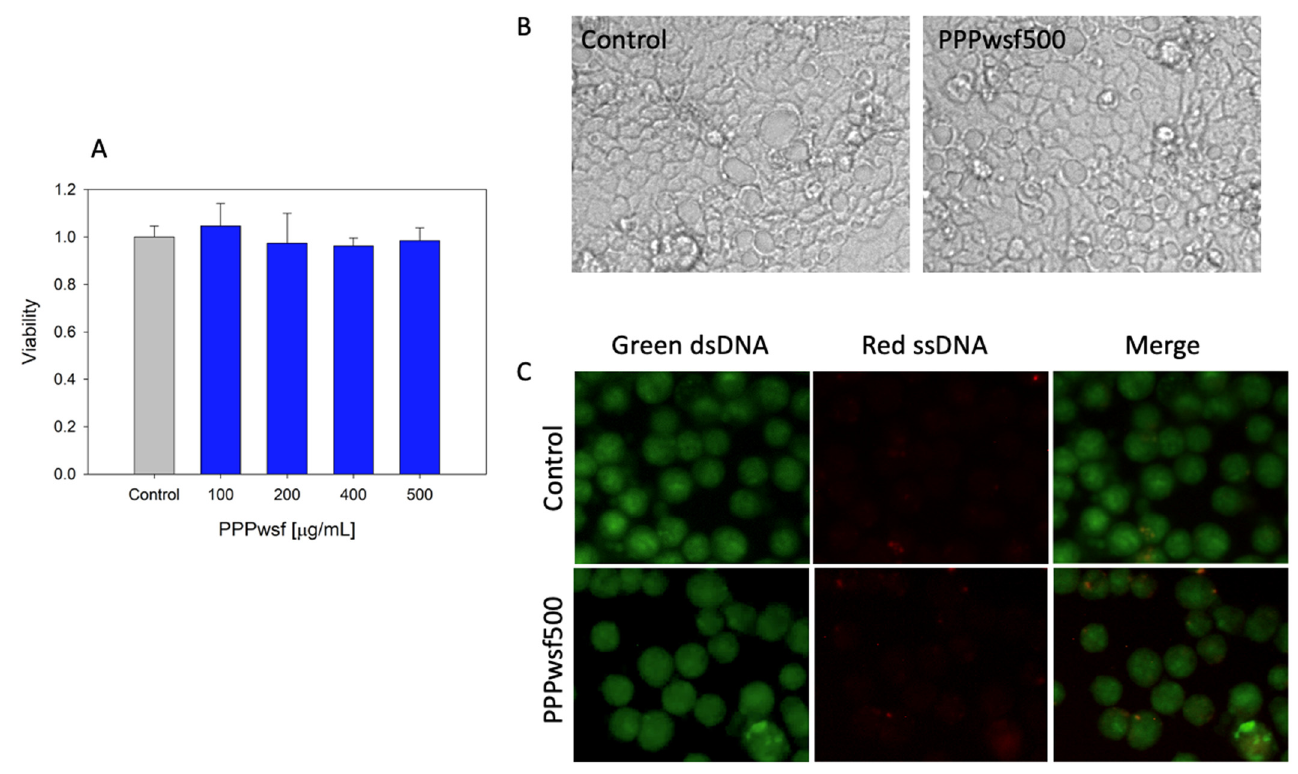
Figure 2. Cytotoxicity test of the PPPwsf solutions: ( A ) Cell viability 24 h after the addition of PPPwsf at the concentration of 100 µ g/mL, 200 µ g/mL, 400 µ g/mL, 500 µ g/mL in Caco-2 cell culture. Data were obtained as a percentage with respect to the control sample. ( B ) Visual inspections of the morphology of Caco-2 cells 24 h after the addition of PPPwsf at the concentration of 500 µ g/mL. The morphology of the control is also reported. Magnification 40 × . ( C ) Microscopic fluorescence visualization of the morphology of Caco-2 cells 24 h after the addition of PPPwsf at a concentration of 500 µ g/mL after staining with orange acridine. Data concerning the control were also reported. Magnification 20 ×